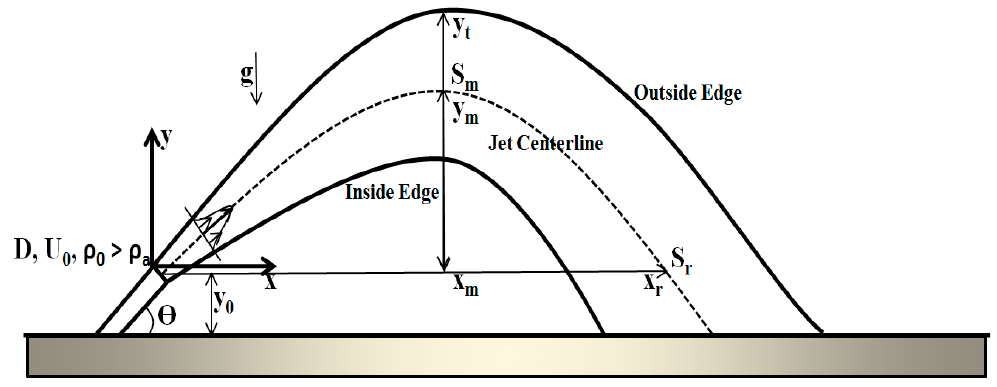
Figure 2. A schematic view of an inclined dense jet with negative buoyancy in stagnant ambient water.